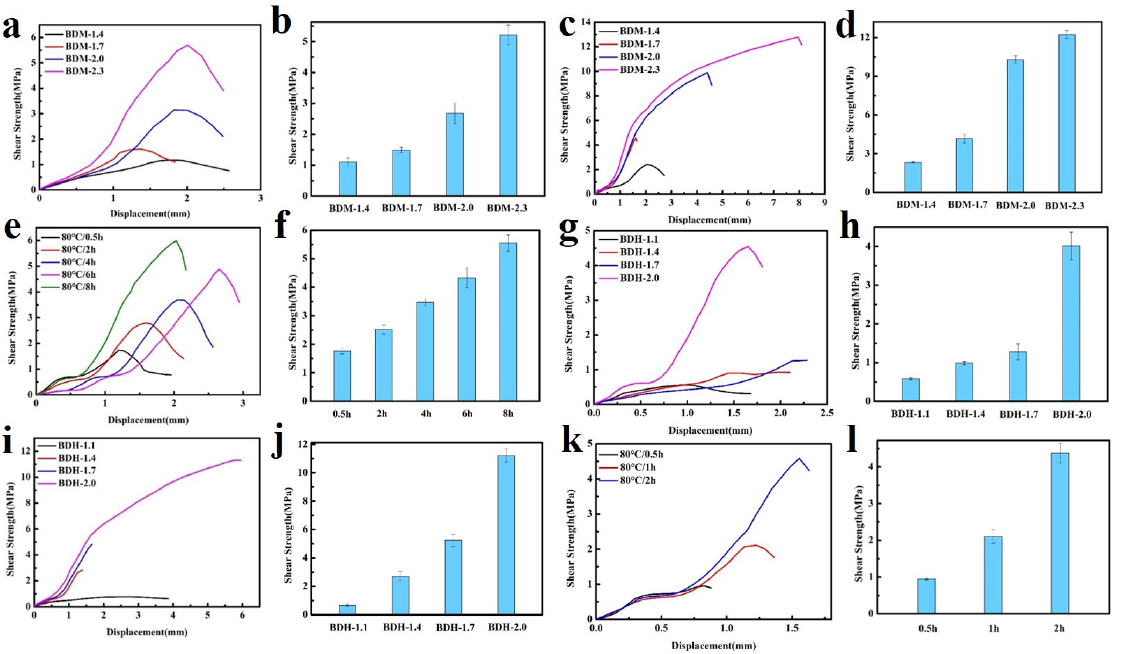
Figure 6. ( a ) Shear strength-displacement curves of BDM-based elastomer at 80 °C for 8 h; ( b ) Shear strength of BDM-based elastomers at 80 °C for 8 h; ( c ) Shear strength-displacement curves of BDM-based elastomer at 150 °C for 0.5 h; ( d ) Shear strength of BDM-based elastomers at 150 °C for 0.5 h; ( e ) Shear strength-displacement curve of BDM-2.3 elastomers at 80 °C for 0.5, 2, 4, 6, and 8 h; ( f ) Shear strength of BDM-2.3 elastomers at 80 °C for 0.5, 2, 4, 6, and 8 h; ( g ) Shear strength-displacement curves of BDH-based elastomer at 80 °C for 8 h; ( h ) Shear strength of BDH-based elastomers at 80 °C for 8 h; ( i ) Shear strength-displacement curves of BDH-based elastomer at 150 °C for 0.5 h; ( j ) Shear strength of BDH-based elastomers at 150 °C for 0.5 h; ( k ) Shear strength-displacement curve of BDH-2.0 elastomers at 80 °C for 0.5, 1, and 2 h; ( l ) Shear strength of BDH-2.0 elastomers at 80 °C for 0.5, 1, and 2 h.